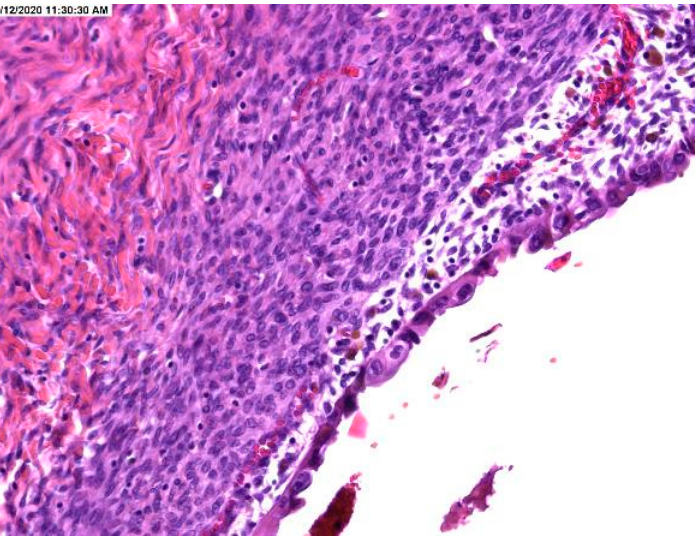
Figure 1. Area of endometriotic cyst showing epithelial lining with larger nuclei, pleomorphism, and high nuclear to cytopalmatic ratio, consistent with atypical endometriosis.